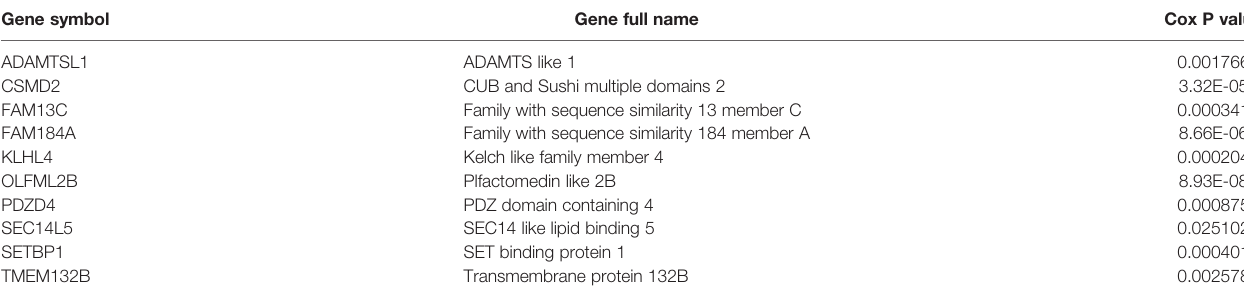
TABLE 3 | Survival-associated gene signature screening using forward